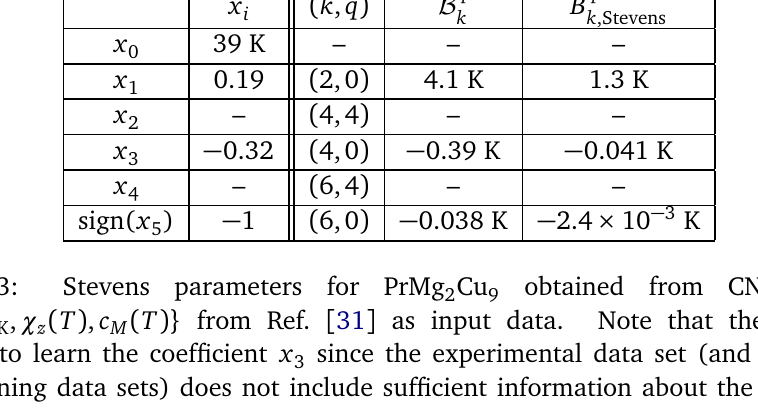
obtained from CNN using 2 The coefficients x